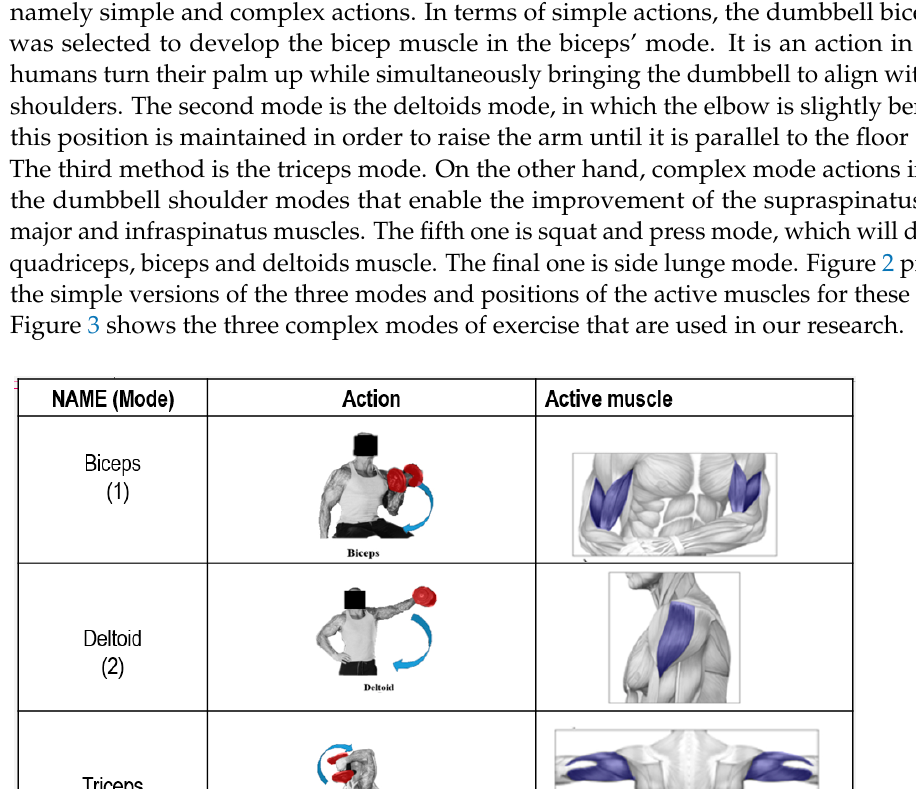
Figure 1. Prototype of hex dumbbell.